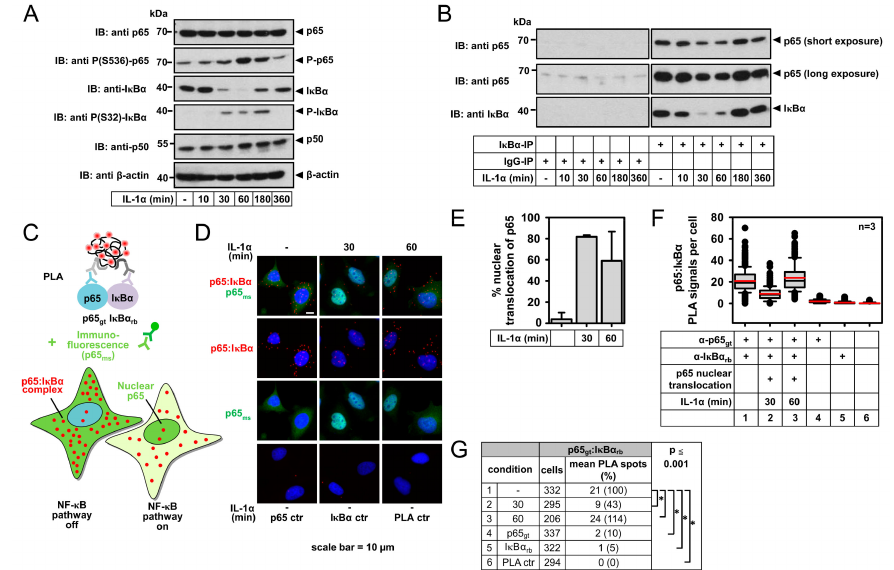
Figure 3. Global functional analysis of p65 / I κ B α complex formation by co-immunoprecipitation compared to PLA analysis specifically in cells with nuclear translocation of p65. ( A ) HeLa cells were stimulated for the indicated periods with IL-1 α (10 ng / mL) as shown. Extracts were prepared and equal amounts of proteins were analyzed by Western blotting for the occurrence and phosphorylation of the indicated proteins with specific antibodies. The position of molecular weight markers is